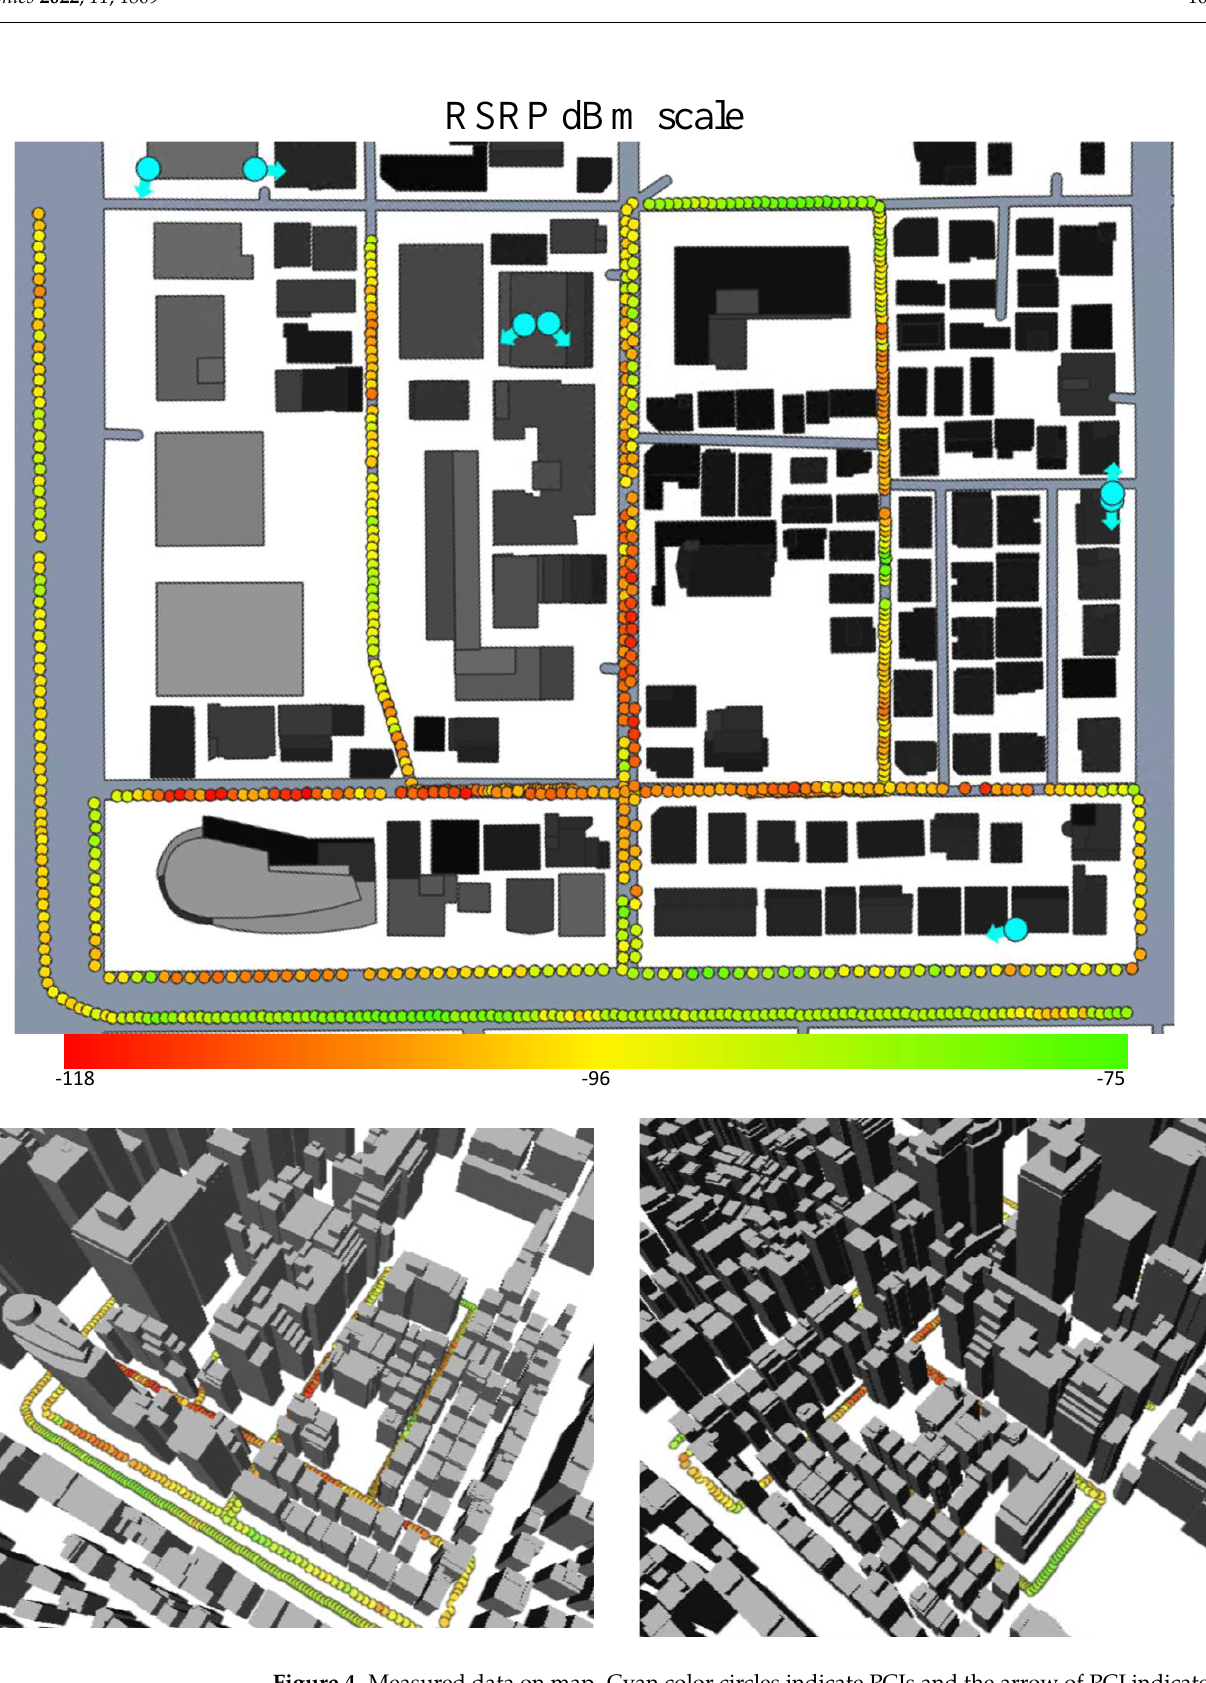
Figure 4. Measured data on map. Cyan color circles indicate PCIs and the arrow of PCI indicates the Azimuth setting itself. The circles on the road represent RSRP values measured by the receiver at each location.